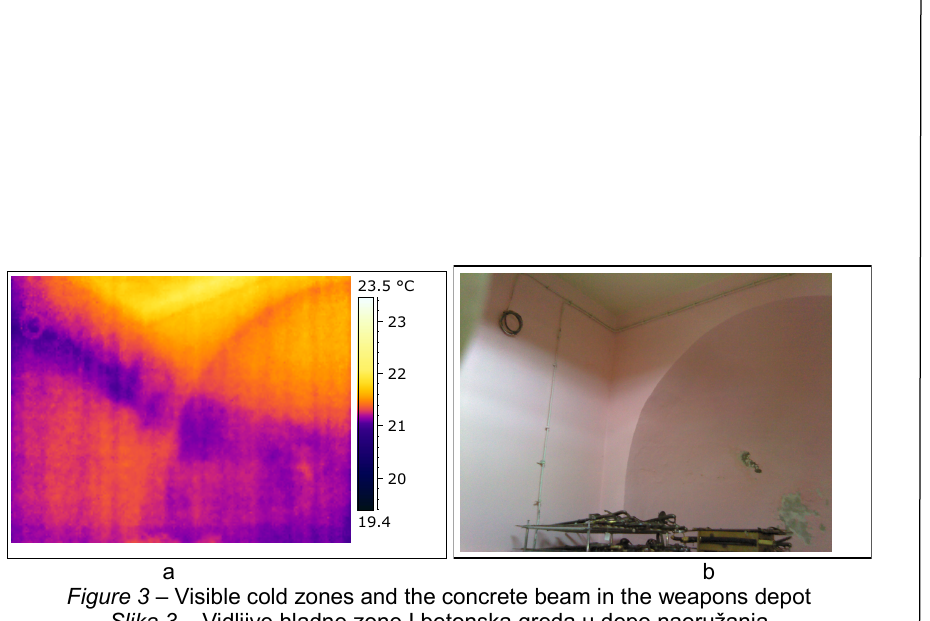
Figure 3 – Visible cold zones and the concrete beam in the weapons depot